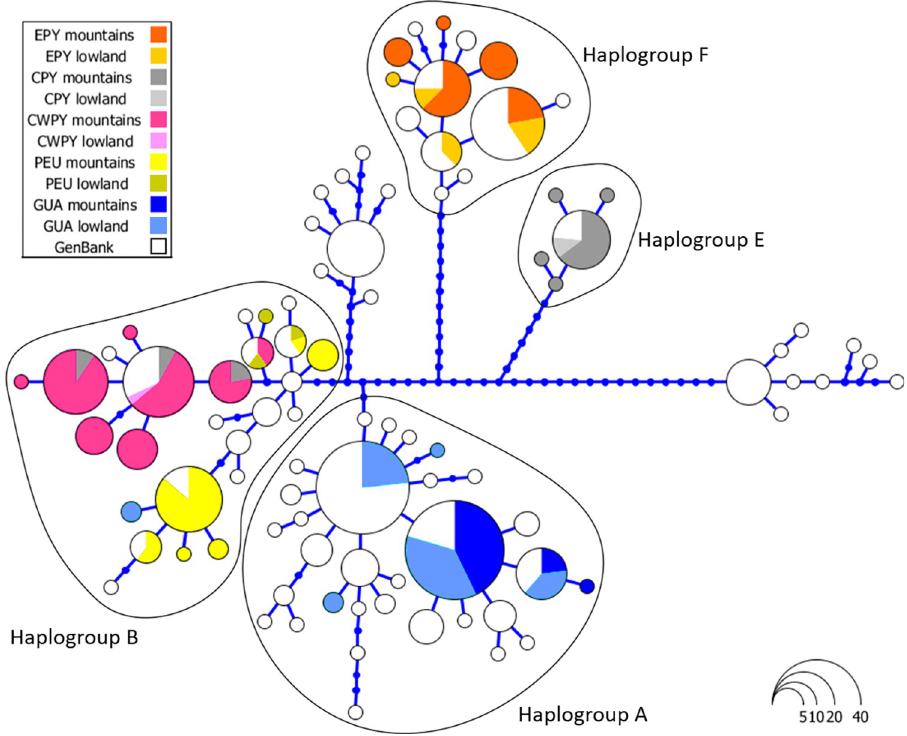
Fig 3. Haplotype network of ND4 sequences analysed in Alytes obstetricans / almogavarii . Each circle represents a unique haplotype and the circle area is proportional to the number of sequences of a given haplotype. Blue dots correspond to inferred unsampled haplotypes. Sequences depicted in white were retrieved from GenBank. The analysed high mountain regions and corresponding lowland areas are indicated by different colours: eastern Pyrenees (EPY, orange), central Pyrenees (CPY, grey), central-western Pyrenees (CWPY, pink), Picos de Europa mountains (PEU, yellow), and Guadarrama Mountain Range and corresponding lowland areas (GUA, blue).